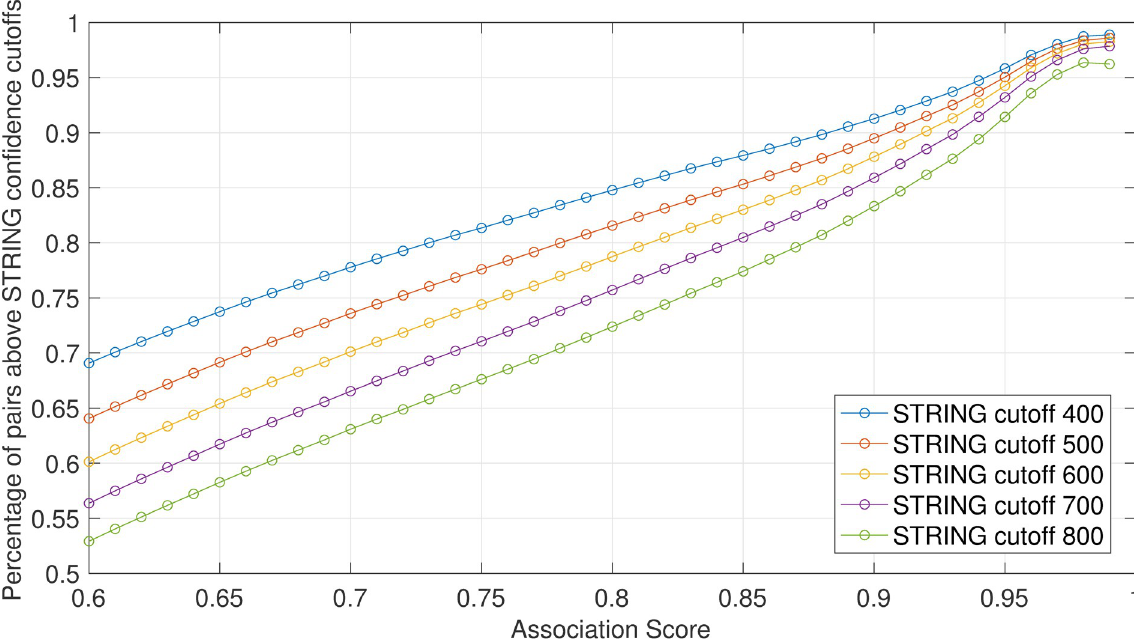
Fig 3. The predicted Association Score between two genes measures the confidence of their associations. The percentage of known STRING pairs above a certain confidence index cutoff. (Note: STRING confidence indexes are discrete scores).